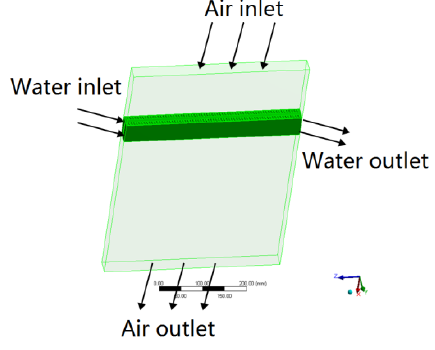
Fig. 2. Fluid domain